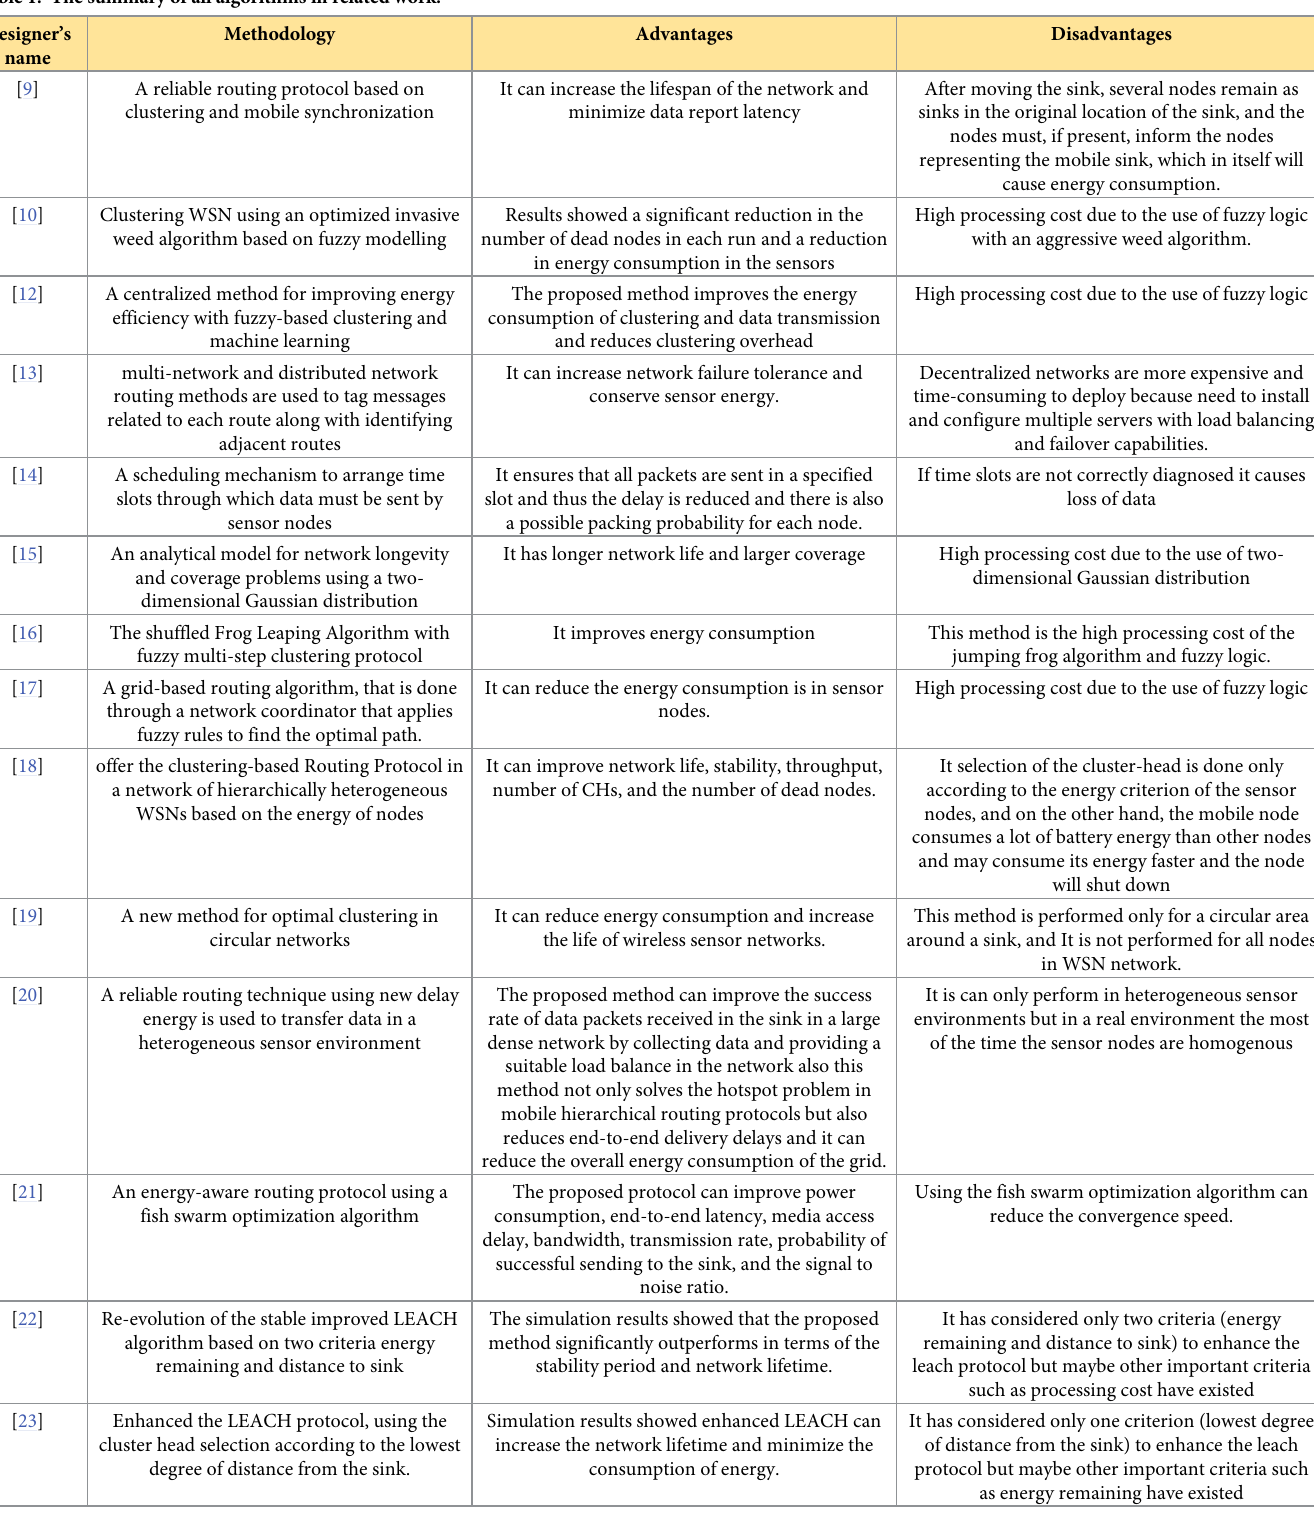
Table 1. The summary of all algorithms in related work. Designer’s